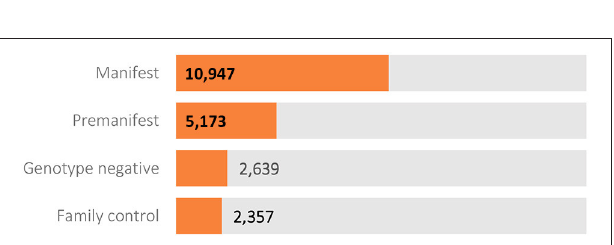
FIGURE 4 | Participant category at Enroll-HD baseline visit ( N =